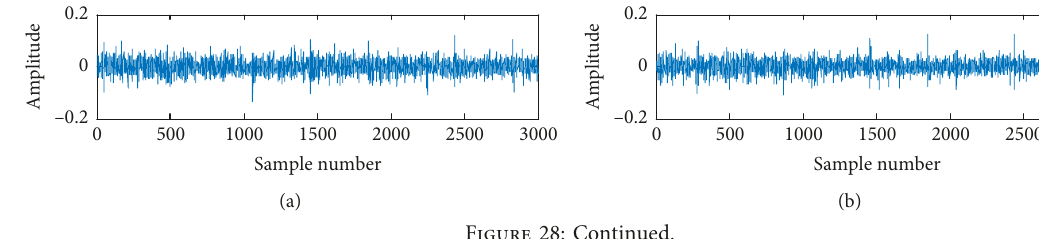
Figure 27: Multiresolution DMD modes of the normal gear signal. We select the first column of X or fast modes. (a)–(h) represent the modes of X Figures 28–30 share the same meanings.